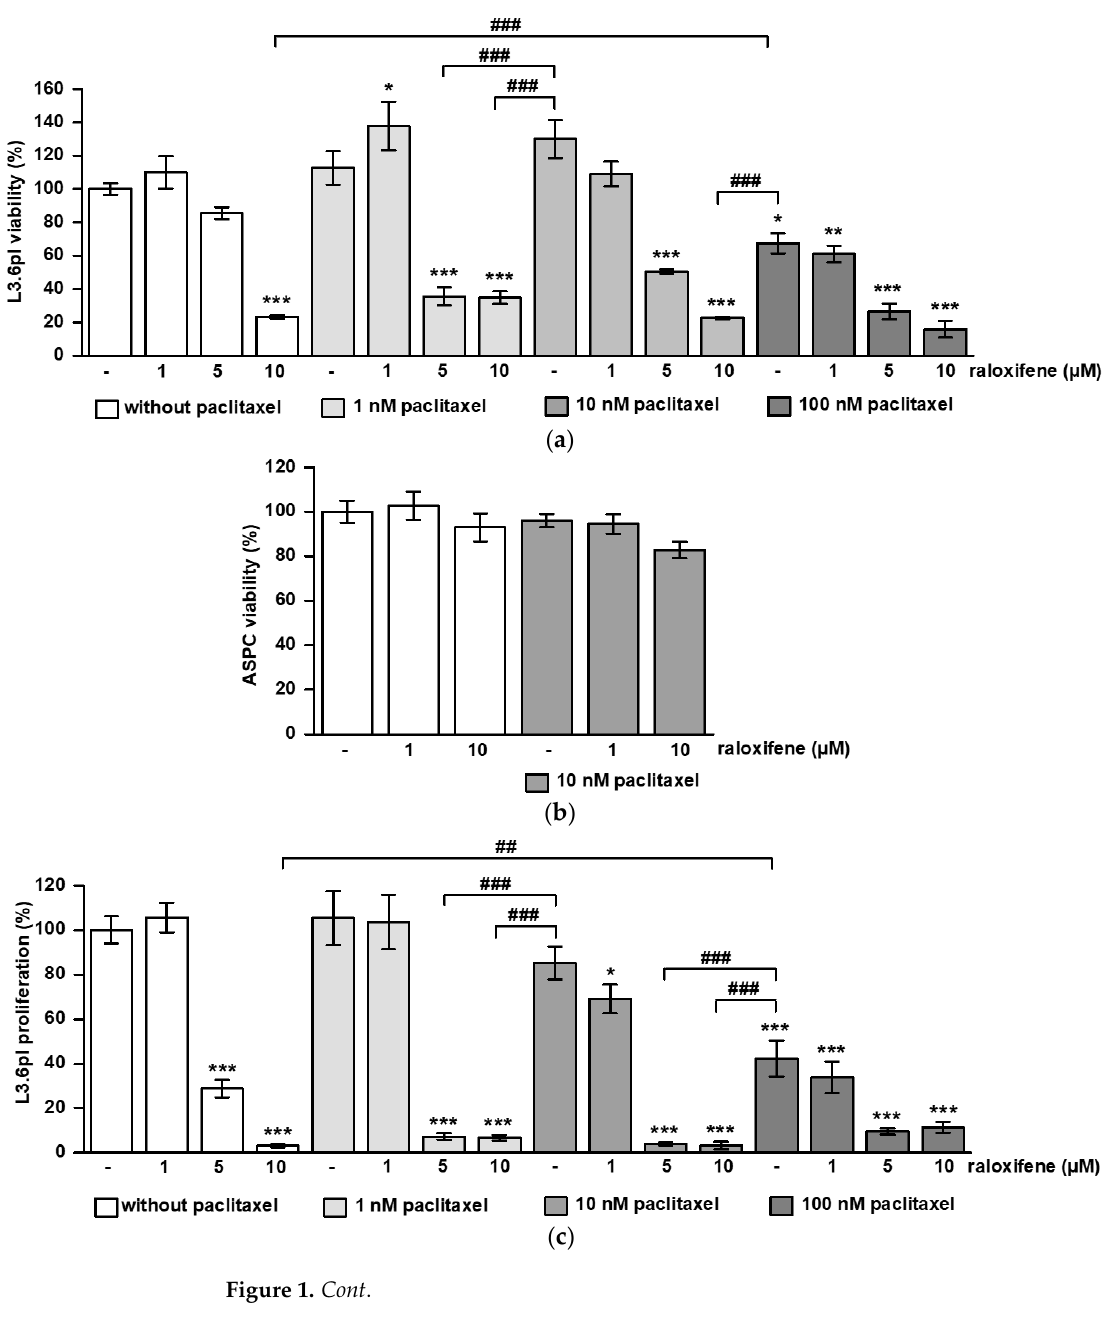
( d ) Figure 1. Synergistic and additive effects of raloxifene and paclitaxel on cell viability and proliferation. L3.6pl and ASPC cells were treated with different concentrations of raloxifene and paclitaxel alone or in combination. The graphs show the results obtained from MTT and BrdU assays on ( a ) cell viability in L3.6pl, ( b ) cell viability in ASPC, ( c ) proliferation in L3.6pl and ( d ) proliferation in ASPC. The data are given as mean values ± SEM from at least two independent experiments; the mean control value was set to 100%. * p < 0.05, ** p < 0.01 and *** p < 0.001 versus control; ## p < 0.01 and ### p < 0.001 versus paclitaxel. 3.2. SC144 Acts Antagonistic on Paclitaxel-Induced Viability and Proliferation Inhibition In Vitro The 1 and 2 µM SC144, as well as 10 nM paclitaxel alone, inhibited cell viability in L3.6pl cells ( p < 0.01, p < 0.001) (Figure 2a). While 1 or 5 nM paclitaxel alone had no effect, combination with 2 µM SC144 diminished viability respectively ( p < 0.001 versus control and versus single paclitaxel treatment). However, combined treatment with 0.1 µM ( p < 0.001), 0.2 µM ( p < 0.001) and 1 µM SC144 blocked the effect of 10 nM paclitaxel on viability reduction (Figure 2a). This is also reflected by the synergy score of -16, suggesting that SC144 and paclitaxel act antagonistic. In ASPC cells, a dose of 5 nM paclitaxel was tested that inhibited cell viability ( p < 0.001) (Figure 2b). The 1 and 2 µM SC144 alone reduced cell viability as well ( p < 0.001 versus control and versus paclitaxel). This effect was not further enhanced by paclitaxel in combination (Figure 2b). Very similar results were obtained from proliferation assays. The 2 µM SC144 inhibited proliferation alone ( p < 0.001) or in combination with 1 or 5 nM paclitaxel ( p < 0.001 versus control and versus paclitaxel) in L3.6pl cells (Figure 2c). Although there was no statistical significance, again, an antagonistic effect of 0.1, 0.2 and 1 µM SC144 on 10 nM paclitaxel-induced proliferation inhibition was observed (Figure 2c). The synergy score was -11, underlining the antagonistic action. In ASPC, proliferation was reduced by 1 and 2 µM SC144 alone or in combination with 5 nM paclitaxel ( p < 0.001 versus control, p < 0.01 and p < 0.001 versus paclitaxel). Again, paclitaxel did not enhance the effects observed with the single SC144 treatment (Figure 2d).